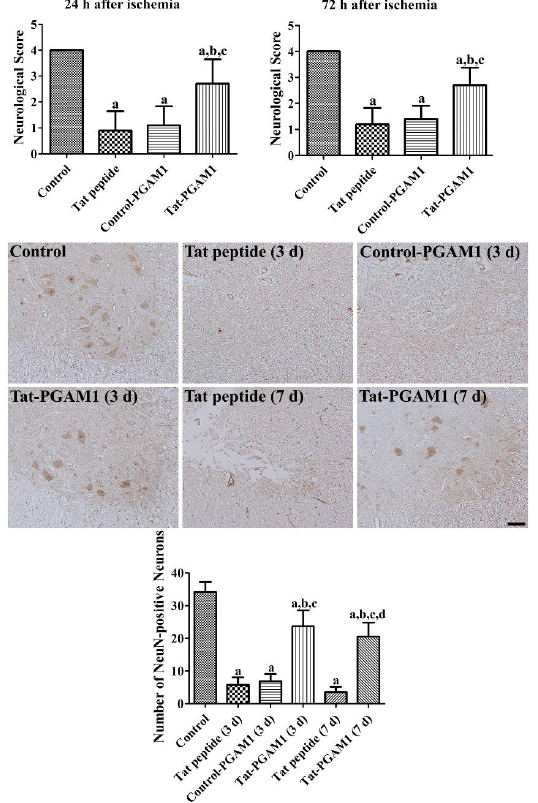
Figure 3. The protective effects of Tat-PGAM1 and Control-PGAM1 against ischemic damage in the rabbit spinal cord. Neurological scores of the control, Tat peptide-, Control-PGAM1-, and Tat-PGAM1-treated groups were measured using the modified Tarlov’s criteria at 24 and 72 h after ischemia/reperfusion. The animals were sacrificed 3 days or 7 days after ischemia for NeuN immunohistochemical staining in the lumbar segments (L 6 -L 7 ) of the spinal cord. Scale bar = 100 μm. The number of NeuN-positive cells were counted in the spinal cord per section for all the groups, and the data were analyzed using one-way ANOVA followed by Bonferroni’s post hoc test ( a p < 0.05, significantly different from the control group; b p < 0.05, significantly different from the Tat peptide (3 d) group; c p < 0.05, significantly different from the Control-PGAM1 (3 d) group; and d p < 0.05, significantly different from the Tat peptide (7 d) group). Th bar graph represents the mean ± standard deviation (SD).